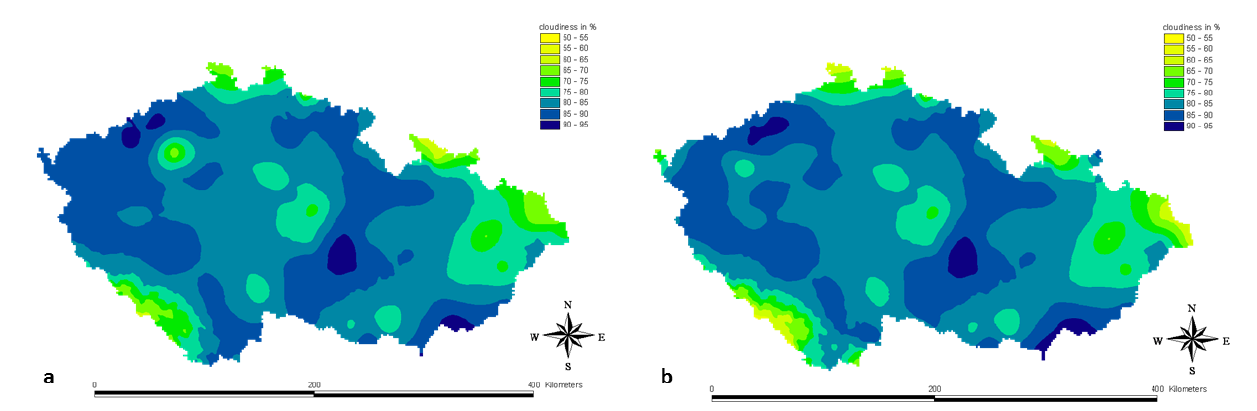
Figure 7. Average monthly cloudiness for November 2012: ( a ) Only station data based on the sunshine duration; ( b ) combination of station and CMSAF